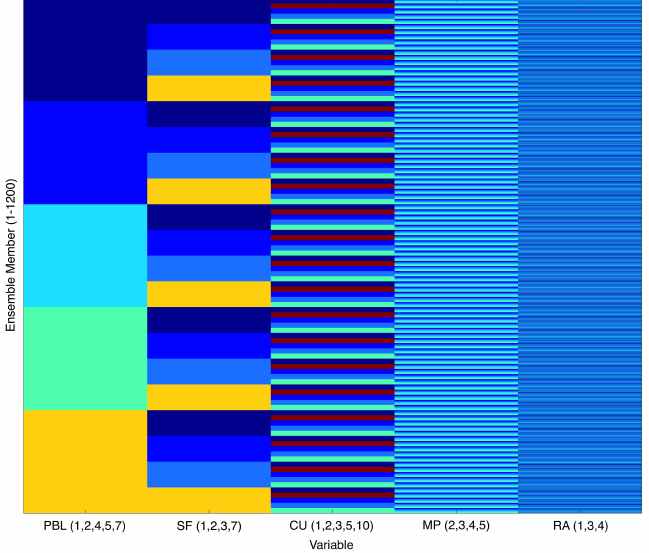
Figure 1. WRF parameterizations were varied as illustrated to create the multi-physics ensemble by iterating through the schemes in the order PBL, LSM, CU, MP, and